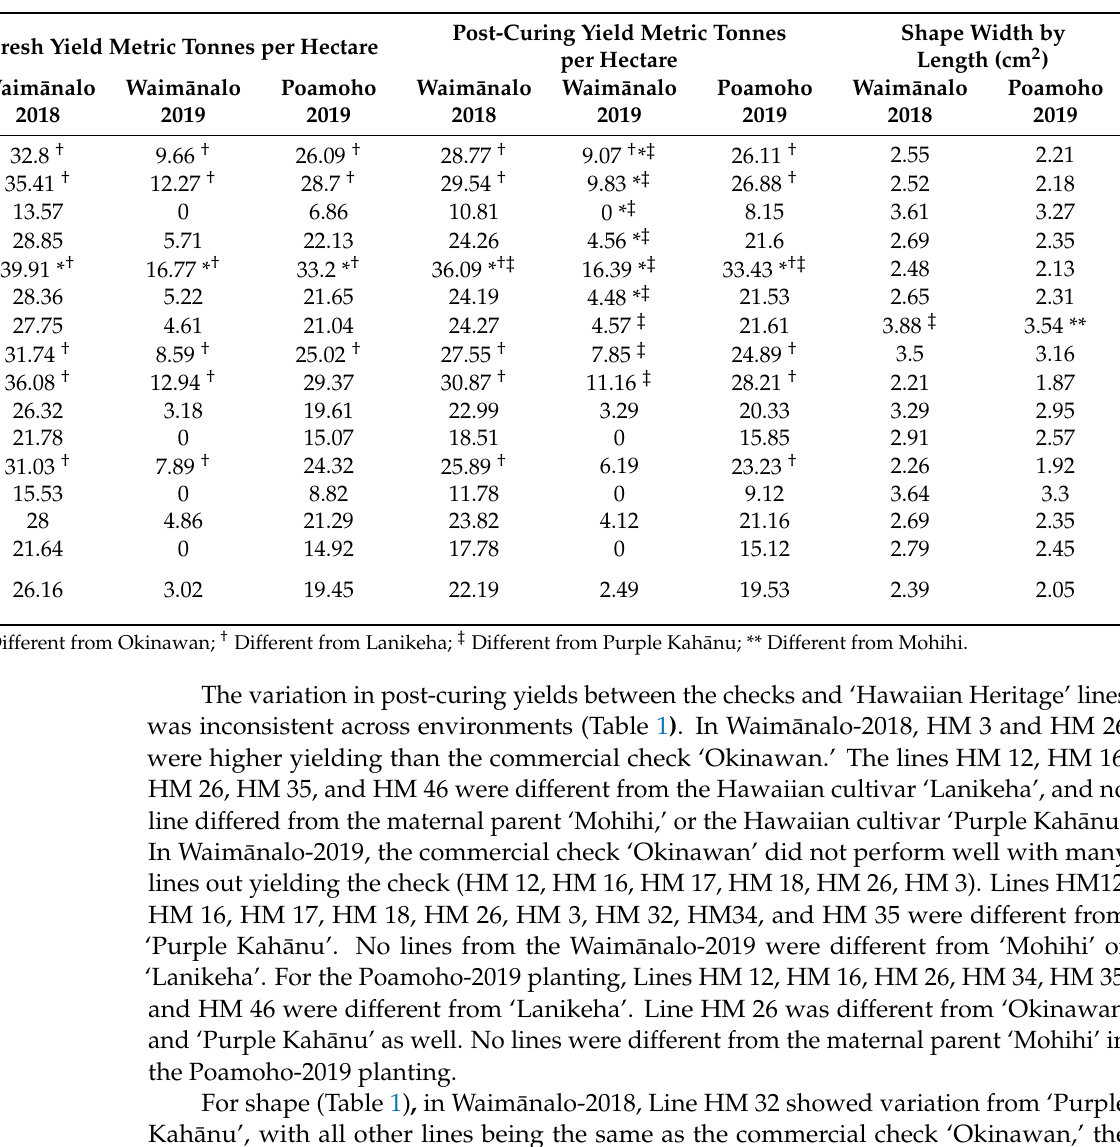
Table 1. Least Square Means for Yield and